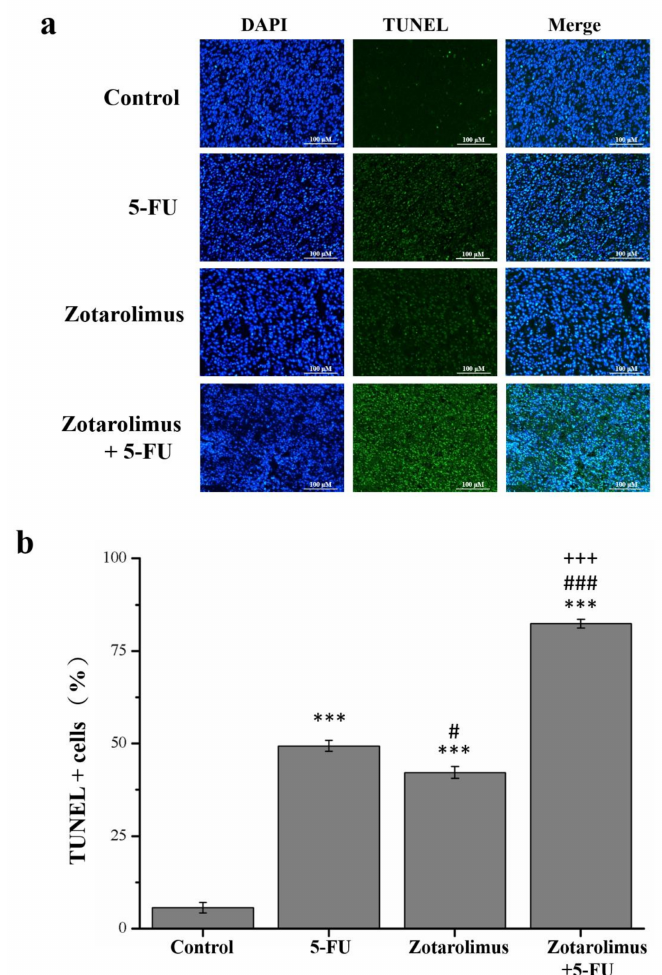
Figure 2. Analysis of apoptosis in HCT-116 tumors by TUNEL/DAPI staining ( × 200). ( a ) Images of TUNEL and DAPI staining and merge. ( b ) Percentage of TUNEL positive cells in the HCT- 116 tumor mass of control BALB/c nude mice and mice administered different treatments: 5-FU (50 mg/kg/week), zotarolimus (2 mg/kg/day), and zotarolimus (2 mg/kg/day) combined with 5-FU (50 mg/kg/week). All data are presented as mean ± standard deviation, n = 8 per group. *** p < 0.001 compared with the control group. # p < 0.05 compared with the 5-FU-treated group. ### p < 0.001 compared with the 5-FU-treated group. +++ p < 0.001 compared with the zotarolimus- treated group. All treatments were initiated on day 7 when tumors were detected. Scale bars = 50 µ